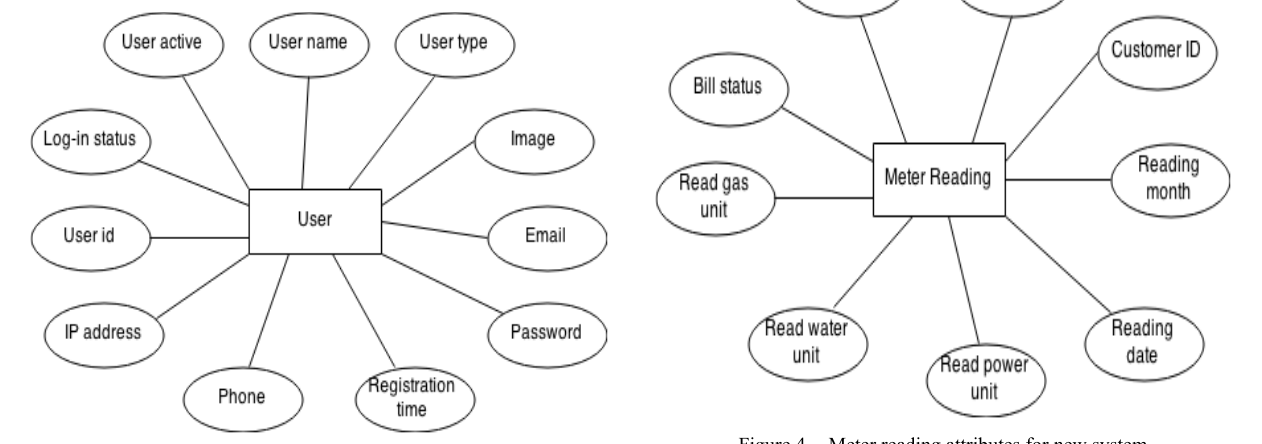
Figure 2. The User Entity and various related attributes